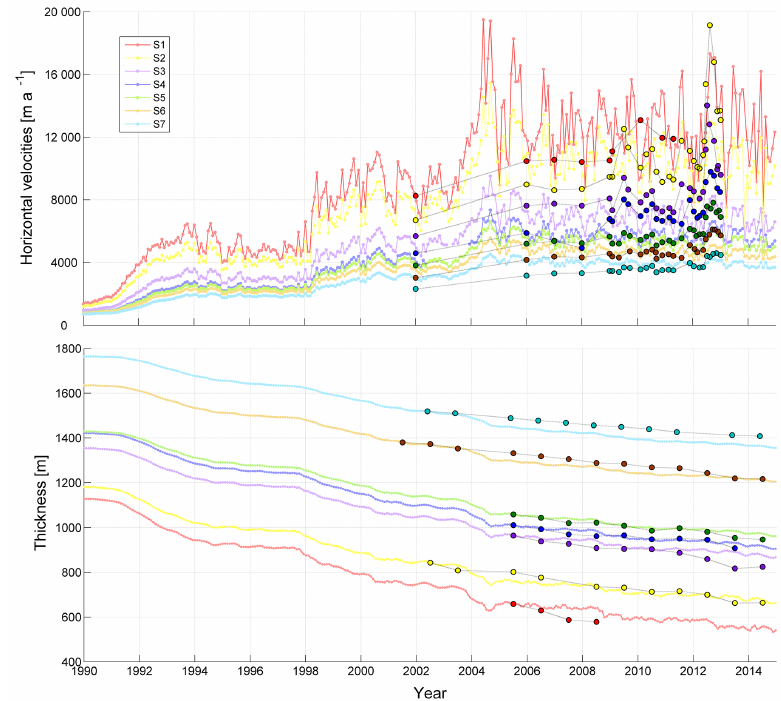
Figure 3. (a) Time series of modelled (filled circles) versus observed (filled circles with black edges) velocities (Joughin et al., 2010) (top figure) and ice thickness changes (Krabill, 2014) (bottom figure) for the period 1990–2014 at locations (S1 to S7) shown in Fig. 1c. The same colour scheme is used for the modelled and the observed data. The observed velocities prior to 2009 are mean winter velocities and are largely consistent with our modelled winter estimates for the same period. The observed thickness has been adjusted to match the model thickness at the first available observation (i.e. by summing the modelled ice thickness corresponding to the first available observation with the observed thickness